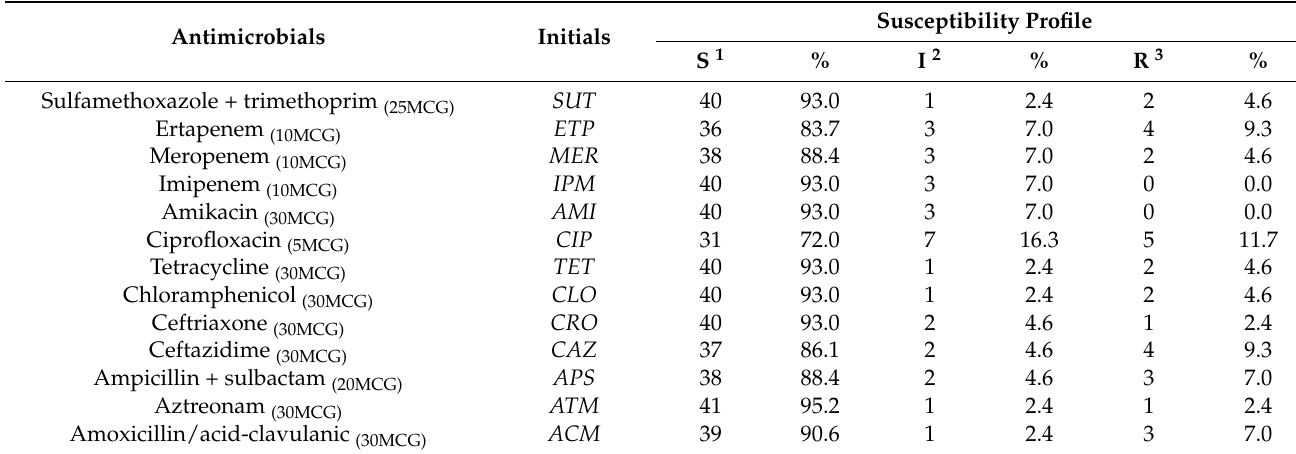
Table 4. Susceptibility profiles of cloacal E. coli isolated from trafficked Psittaciformes under captivity at the Centro de Triagem de Animais Silvestres da Para í ba (CETAS-PB), located in the Restinga de Cabedelo National Forest, Brazil. Antimicrobials Sulfamethoxazole + trimethoprim (25MCG)